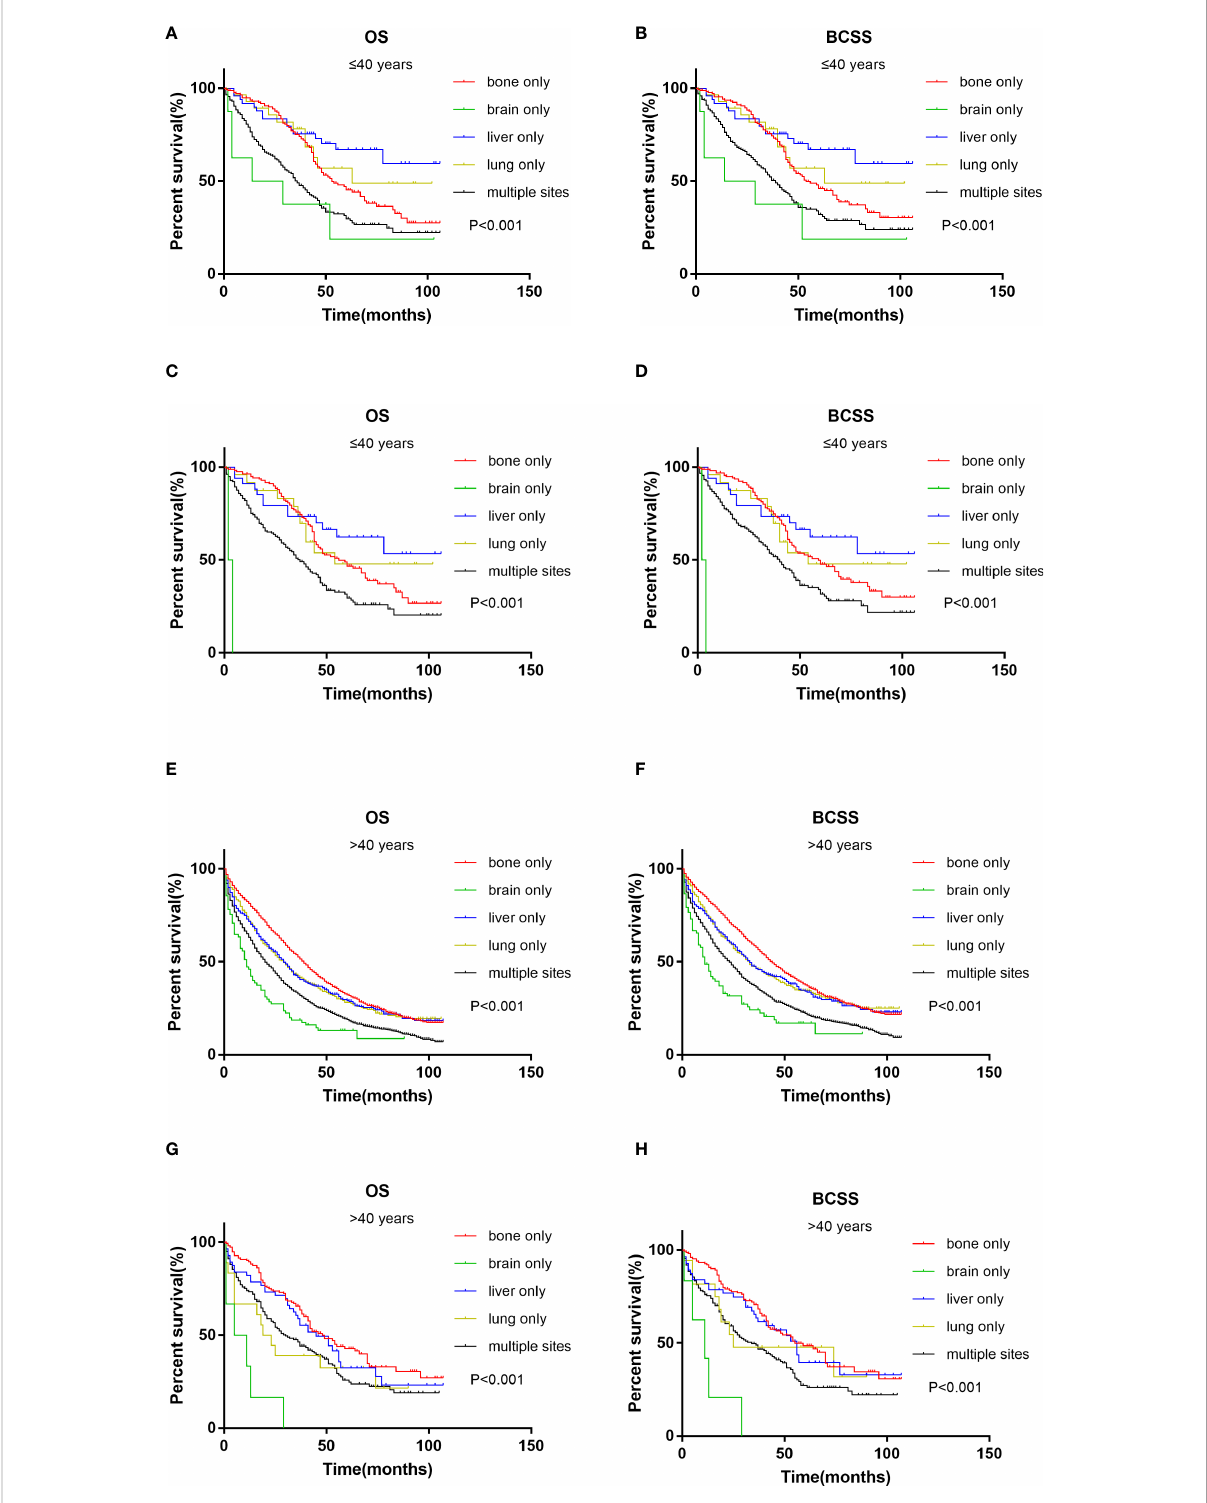
FIGURE 3 Kaplan – Meier curve of overall survival and cancer-speci fi c survival according to metastasis sites in younger ( ≤ 40 years) groups before (A, B) and after (C, D) PSM; Kaplan – Meier curve of overall survival and cancer-speci fi c survival according to metastasis sites in older (>40 years) groups before (E, F) and after (G, H)